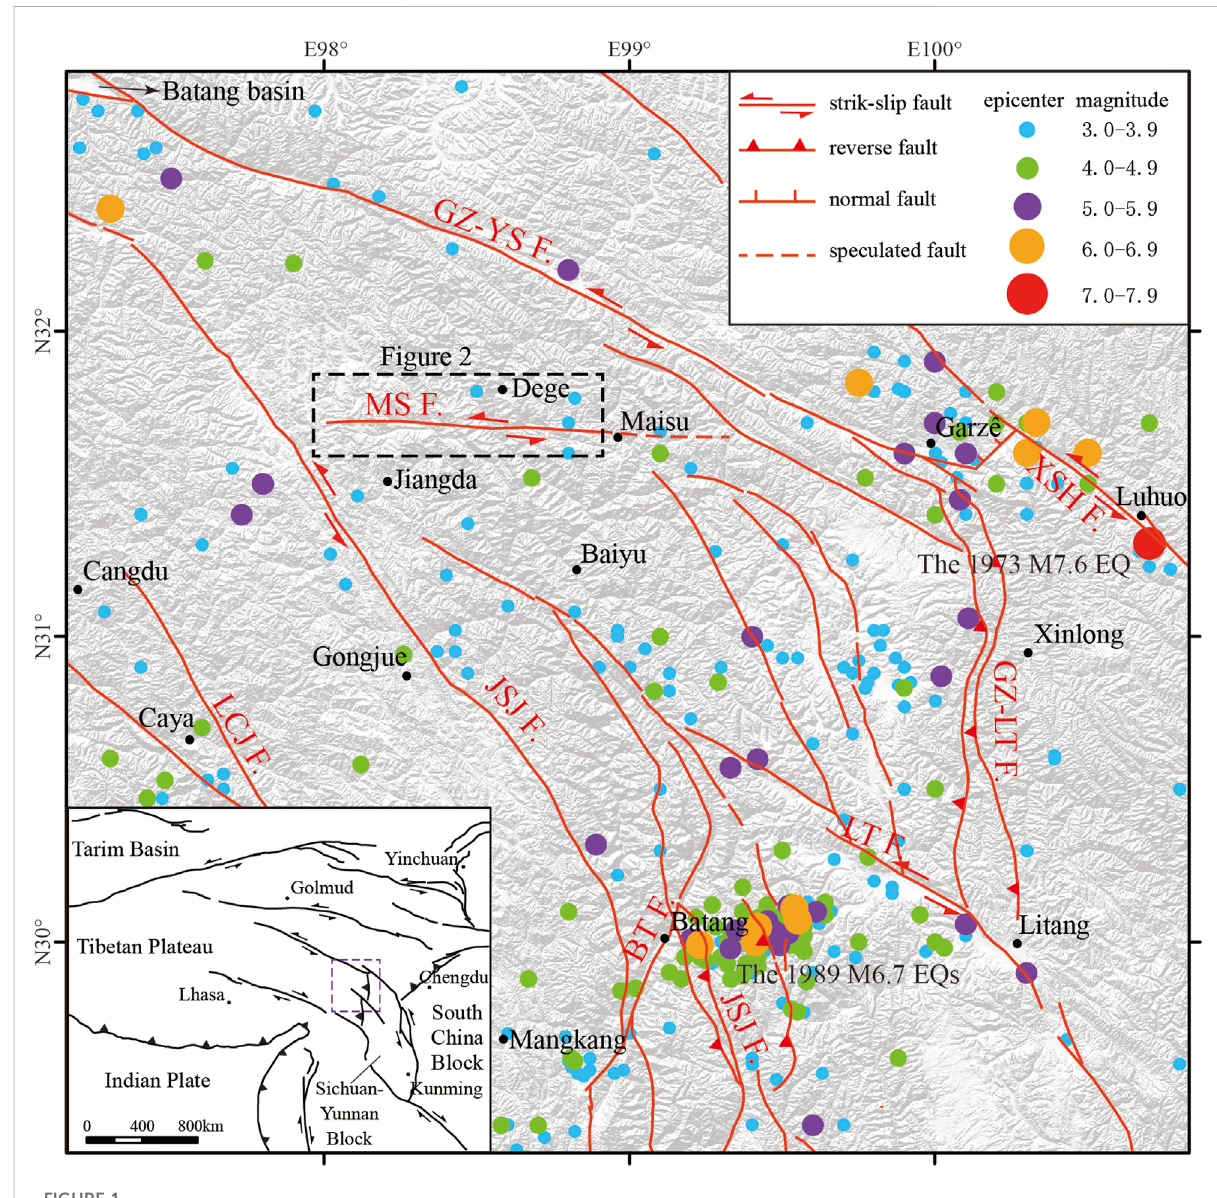
FIGURE 1 Distribution of the main faults and strong earthquakes within the study region. GZ-YS F, The Garzê – Yushu fault; XSH F, The Xianshuihe fault; GZ-LT F, The Garzê – Litang fault; MS F, The Maisu fault; LT F, The Litang fault; JSJ F, The Jinshajiang fault; BT F, The Batang fault; and LCJ F, The Lancangjiang